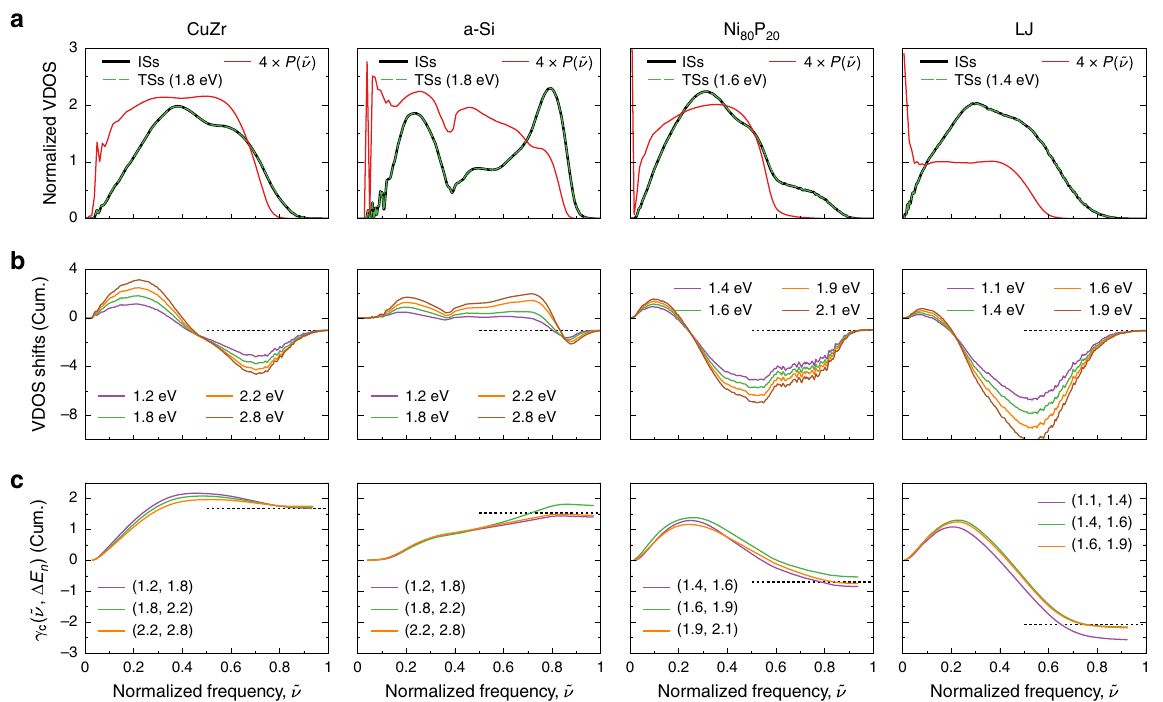
Fig. 2 Vibrational origin of compensation and anti-compensation. a Normalized VDOS averaged over all ISs (black lines) and most probable TSs (green dashed lines), as a function of normalized frequencies ~ ν ¼ ν = ν 0 , with ν 0 equal to 9, 20, 15, and 7.5 THz for CuZr, a-Si, Ni80P20, and LJ, respectively. Red lines represent mode participation ratios ( “ Methods ” ), averaged over frequencies and ISs, and multiplied by four so that their values can be read on the y axis used for normalized VDOS. b Cumulative VDOS shifts between TSs — whose activation energy lies in the energy bin centered at Δ E n — and ISs. They converge to − 1 (black dotted lines). Legends indicate approximate values of Δ E n , and line colors correspond to colors of dots in Fig. 1b. c Cumulative ð ~ ν ; Δ E Þ (slopes of the line connecting two consecutive dots in Fig. 1b; these dots lie contributions of vibrational modes to local compensation factors γ n c around the energies ( Δ E n , Δ E n + 1 ) given in legends). They converge around the global compensation factors γ c (black dotted